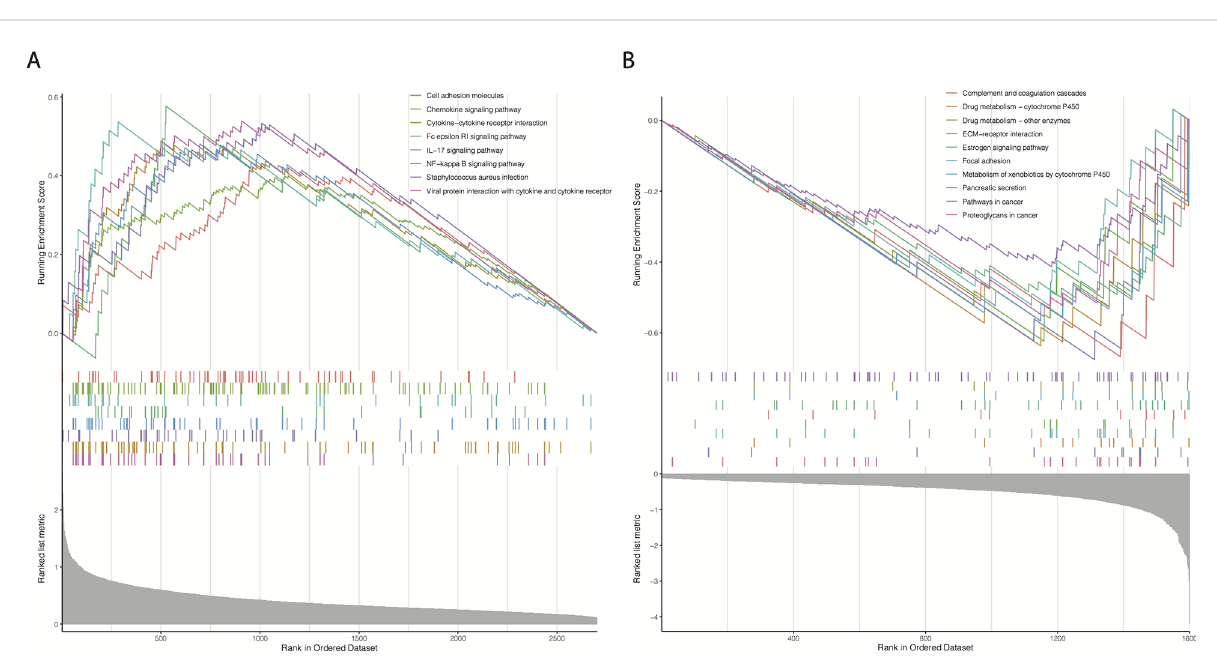
FIGURE 10 Analysis of GSEA pathway differences between different cr-TILCD8TSig